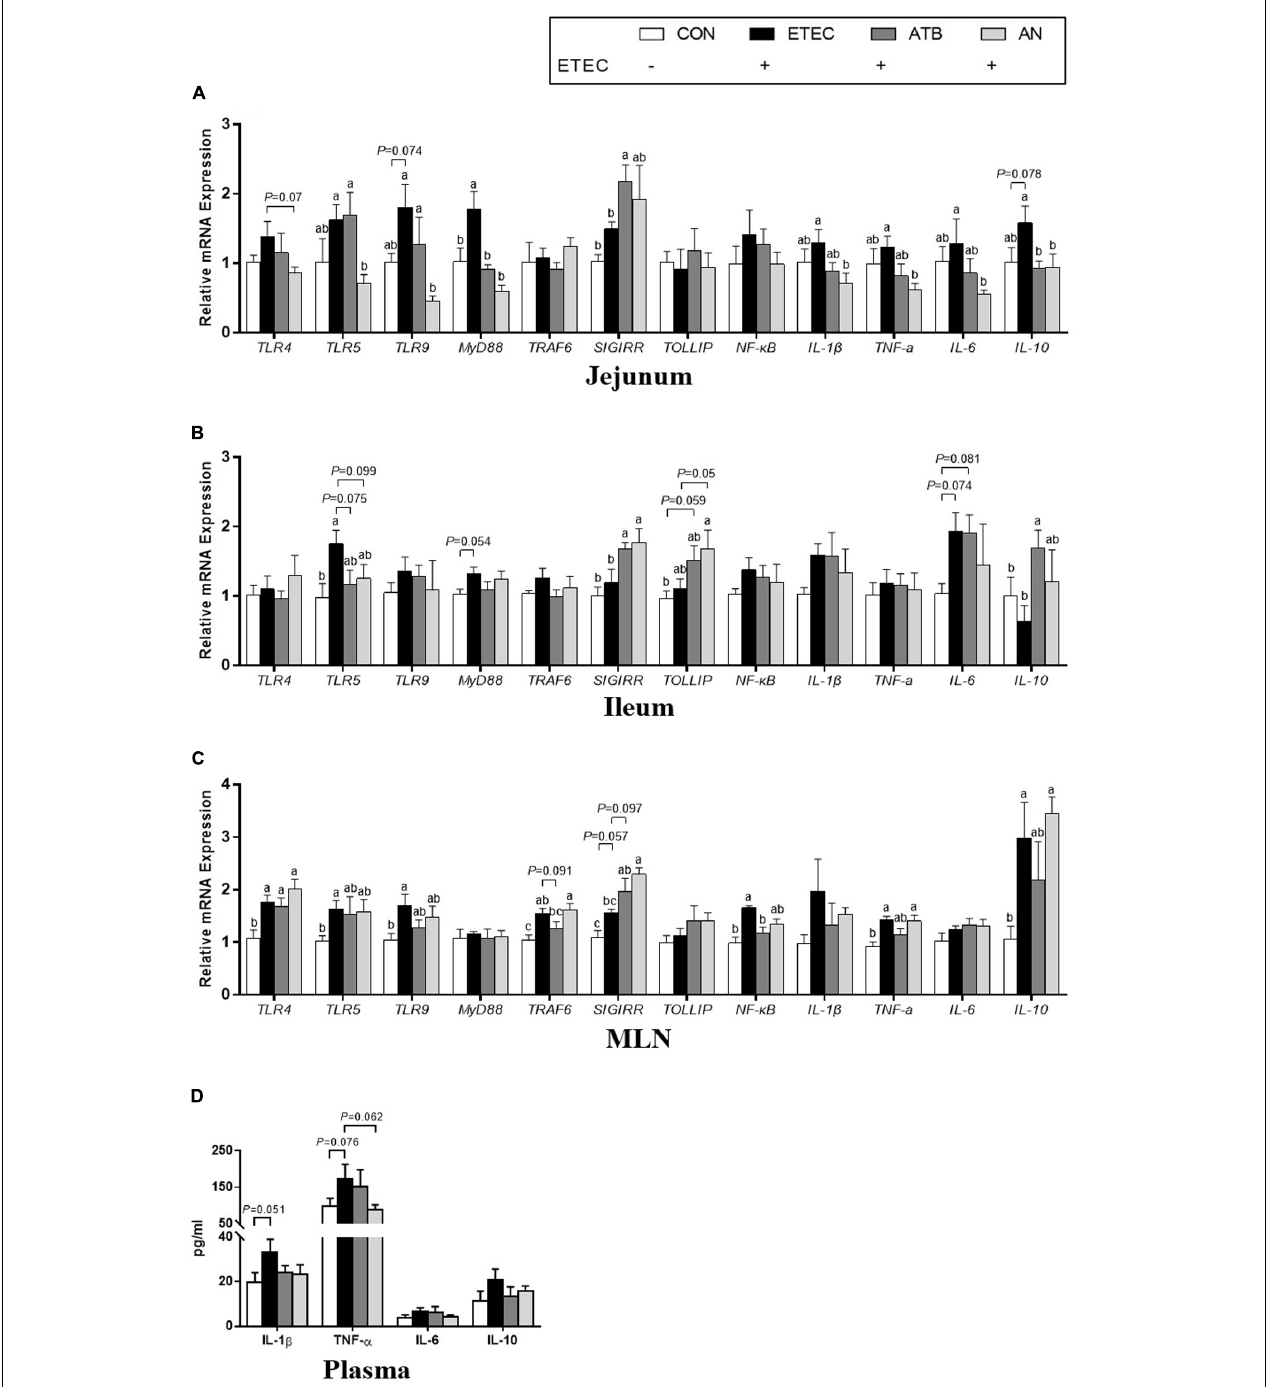
FIGURE 3 | Effects of anethole on concentration of relative mRNA expression of genes related to inflammation (A) jejunum, (B) ileum, (C) MLN, and (D) plasma cytokine and of piglets challenged with enterotoxigenic Escherichia coli K88. ELISA for plasma, n = 9; For PCR assays, n = 8, GAPDH as reference gene; The data in each group is expressed as the mean ± SE. Different letters mean statistically significant difference among the groups ( P <